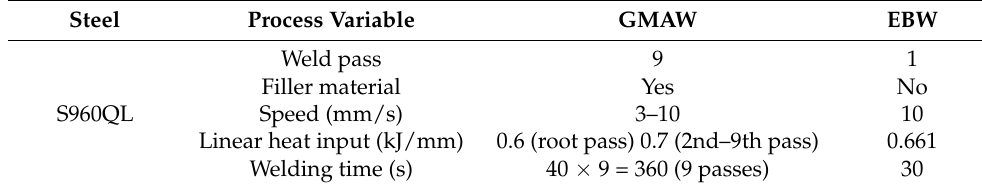
Figure 3. Calculated crossection area of FZ, HAZ and depth of penetration. ( a ) EBW; ( b ) GMAW, M = 6.5 × (2% Nital) data from [26]. Table 7. Comparison of GMAW and EBW process variables.